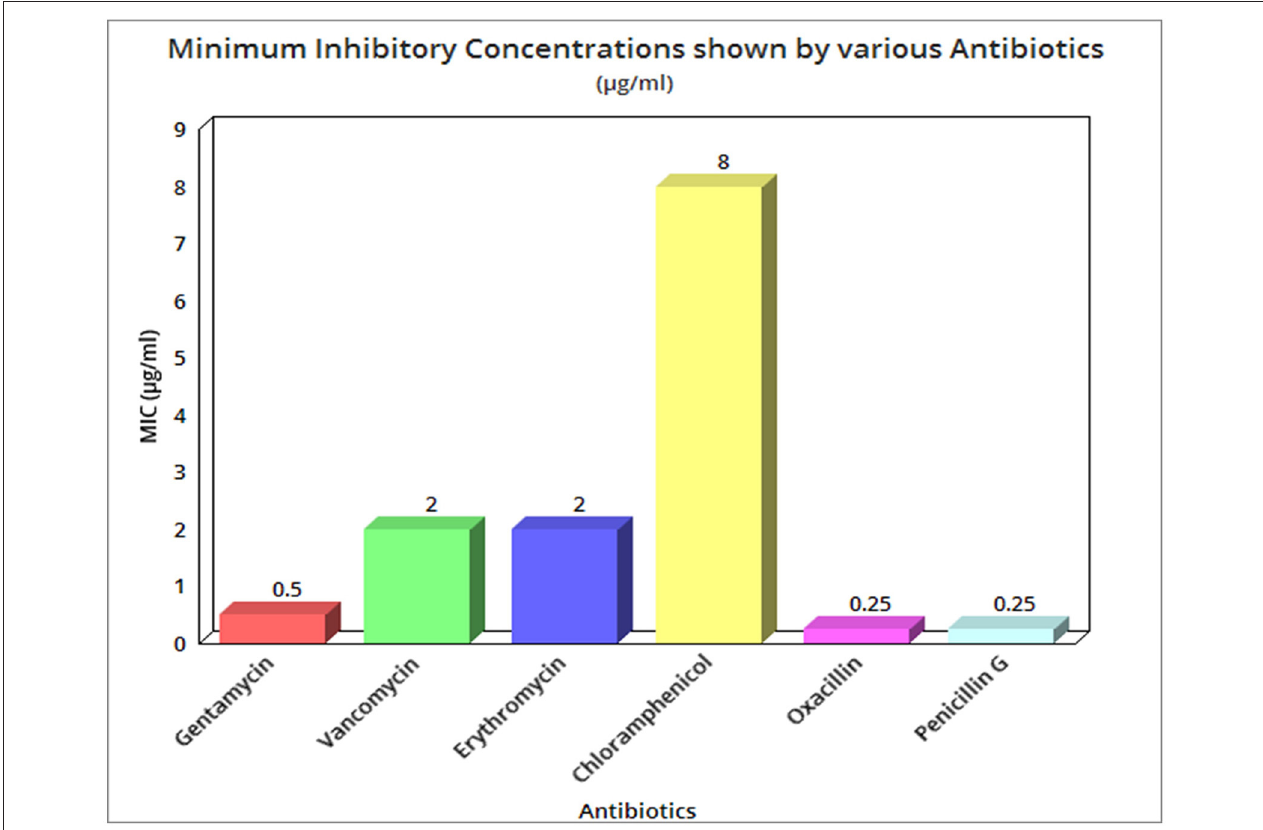
FIGURE 2 | Minimum inhibitory concentration shown by various antibiotics in µ